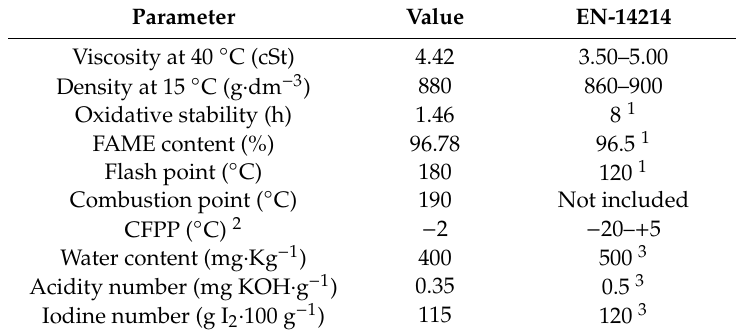
Table 4. Sa ffl ower biodiesel. Characterization and comparison with the EN-14214 standard.